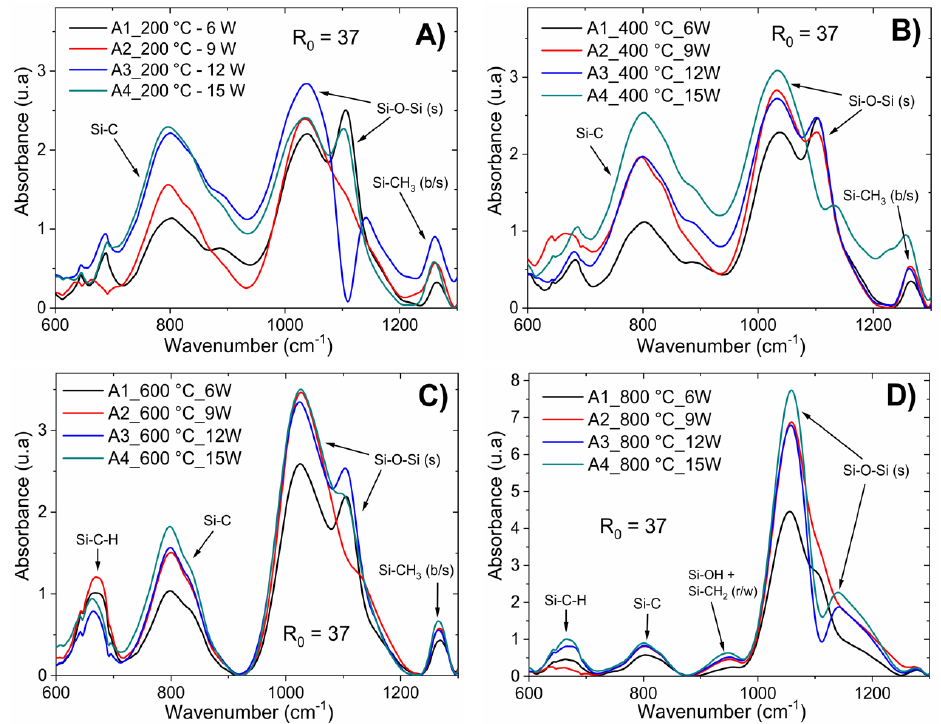
Figure 2. IR spectra for the a-Si 1 – x C x :H films deposited after fast annealing process with different RF power (from 6 – 15 W) while keeping the CH 4 /SiH 4 ratio constant; upon fast annealing process at 200 ( A ), 400 ( B ), 600 ( C ), and 800 °C ( D ).